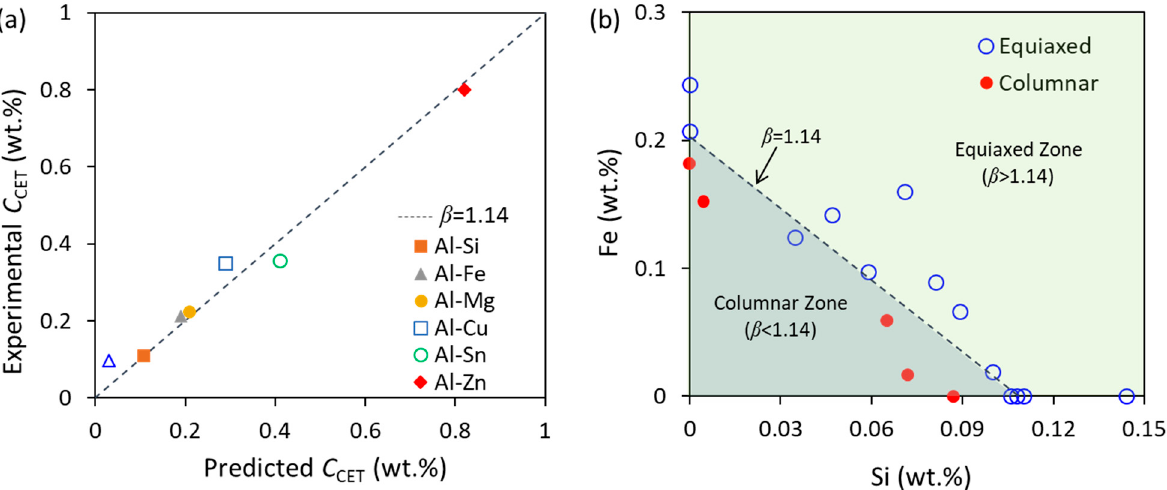
Figure 4. Comparison between the predicted composition for CET by β = 1.14 and the experimental results from the standard TP-1 test [9,87]. ( a ) Binary Al alloys and ( b ) Al-Fe-Si ternary alloys. Reprinted with permission from Ref. [9]. Copyright 2022 Elsevier.